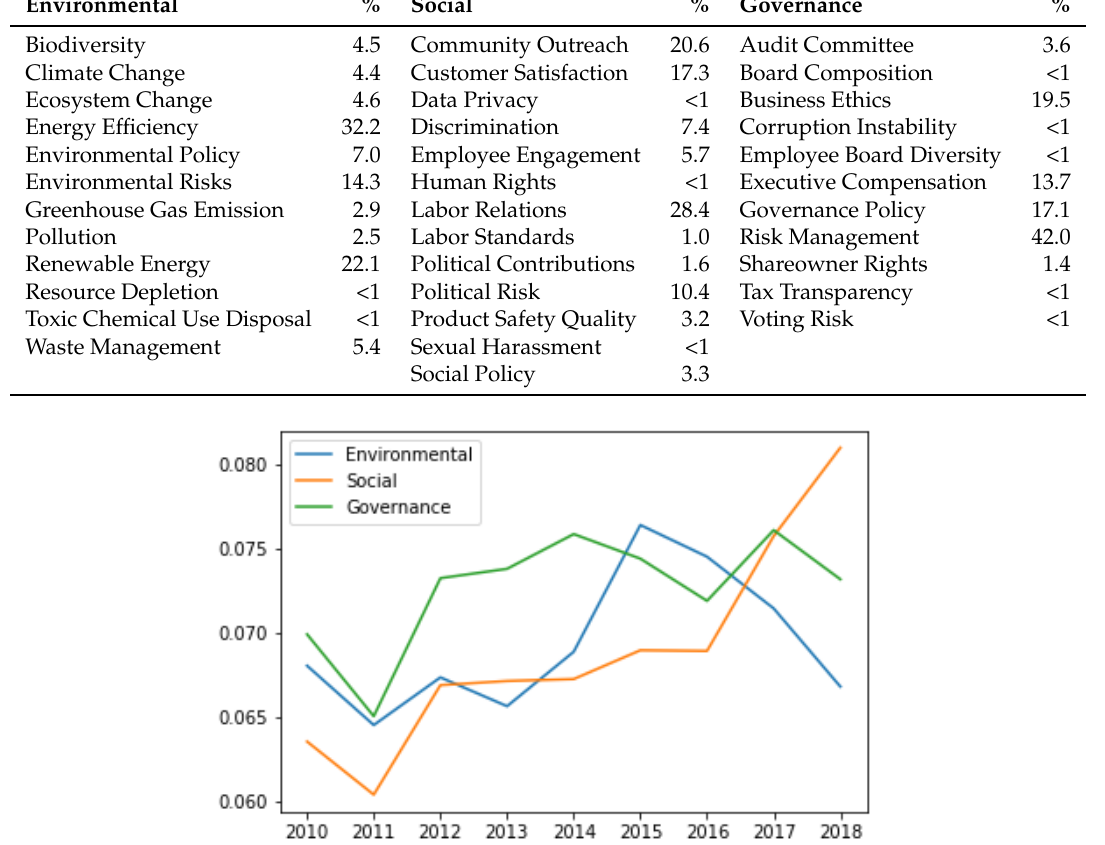
Figure 5. Trend analysis of ESG mentions in earnings calls.